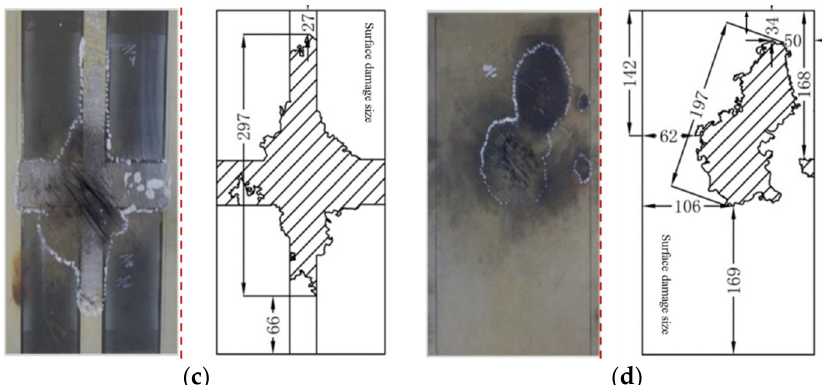
Figure 6. Surface damage pattern and size of four different types of composite-reinforced panels: ( a ) composite-reinforced panel without protection; ( b ) composite-reinforced panel with a full-sprayed aluminum coating; ( c ) composite-reinforced panel with a local-sprayed aluminum coating; ( d ) composite-reinforced panel with a full copper mesh filling. (Unit: mm).